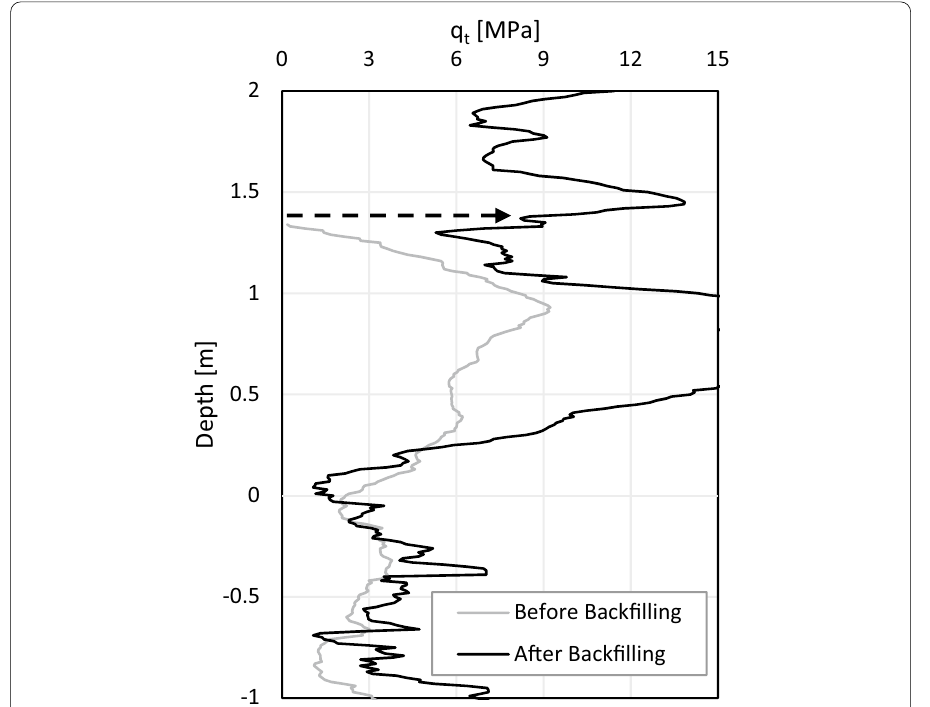
Fig. 4 q t values of pre and post CPT of case N5. The jump of q t at the original ground surface is depicted by the dashed